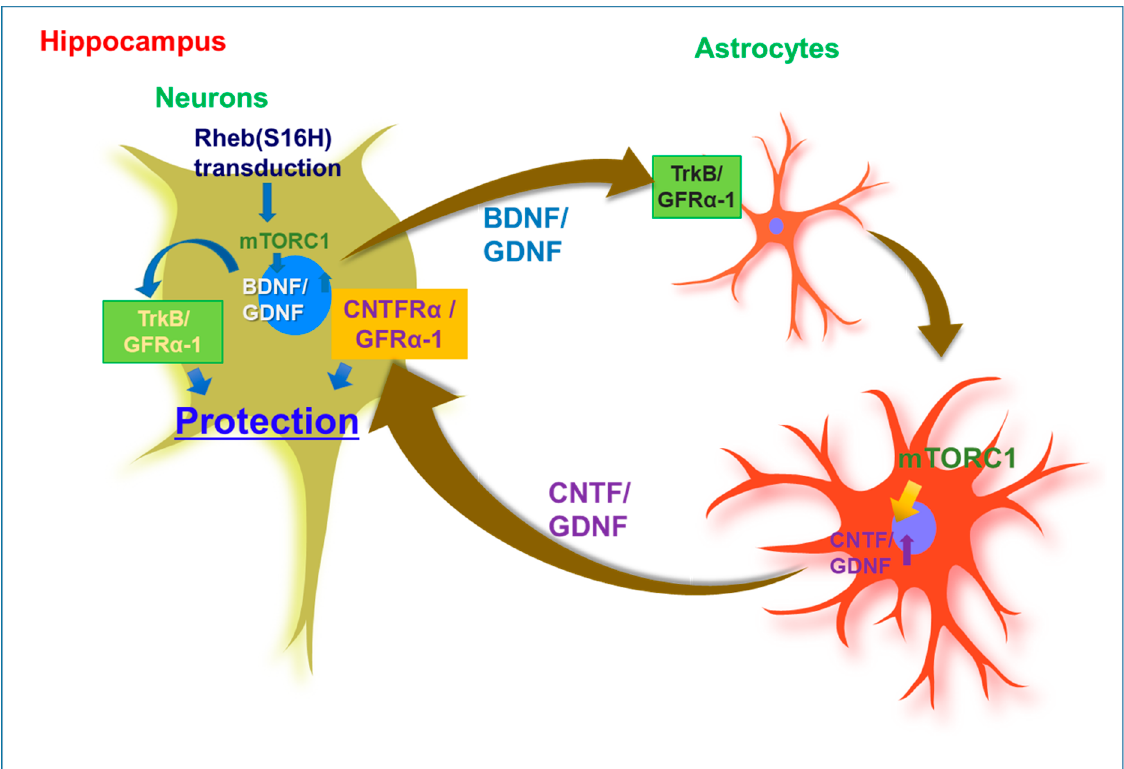
Figure 1. Mechanisms of neuroprotection through neuronal upregulation of mutated ras homolog protein enriched in brain [Rheb(S16H)] in the hippocampus of the adult brain. Upregulation of Brain-derived neurotrophic factor (BDNF) and glial cell line-derived neurotrophic factor (GDNF) by neuronal transduction with adeno-associated virus serotype 1 (AAV1)–Rheb(S16H) can additionally contribute to the activation of BDNF/TrkB and GDNF/GFR α -1 signaling pathways, respectively, in astrocytes via the interactions between neurons and astrocytes in the adult hippocampus, resulting in the production of astrocytic ciliary neurotrophic factor (CNTF) and GDNF for hippocampal neuroprotection. These observations suggest that Rheb(S16H) transduction of hippocampal neurons may be a good strategy to protect adult neurons in the hippocampus in vivo.